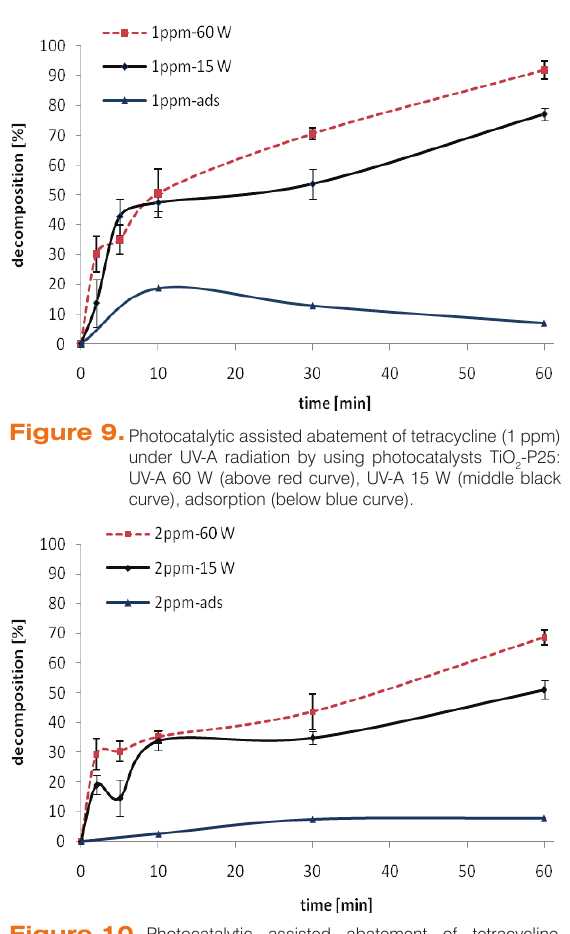
Figure 12. Photocatalytic assisted abatement of tetracycline (500 ppb, 60 W UV-A; 2 mg L -1 TiO -P25) above red 2 curve, contribution of adsorption below blue